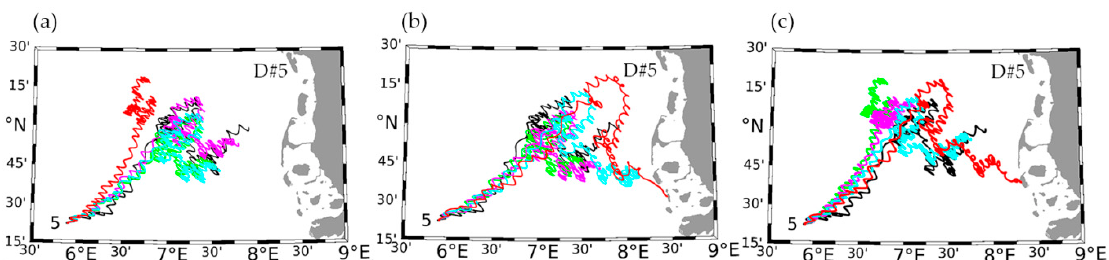
Figure 10. Drifter trajectories: observed (black line) and modelled. The colors of the different experiments are given in the legend in Figure 6 for ( a ), in Figure 7 for ( b ) and in Figure 8 for ( c ).